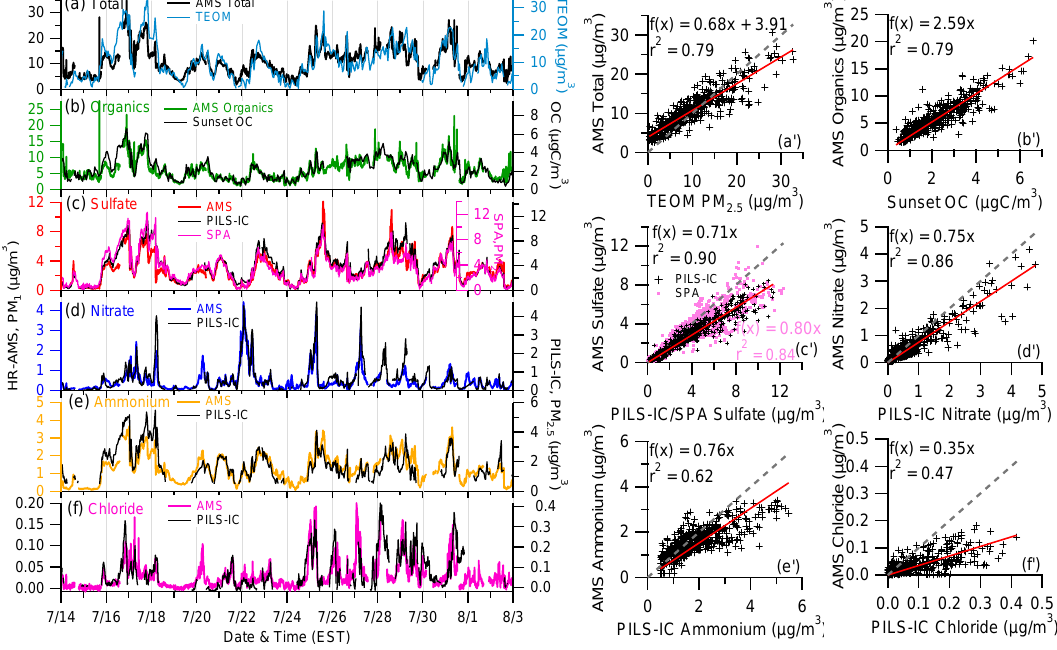
Fig. 1. Inter-comparisons between the NR-PM 1 mass concentrations measured by the HR-MS vs. the data acquired by collocated instruments: (a) total (=organics+sulfate+nitrate+ammonium +chloride) vs. PM 2 . 5 mass by a TEOM, (b) organics vs. PM 2 . 5 OC by a Sunset Lab OC/EC Analyzer, and (c–f) sulfate, nitrate, ammonium, and chloride vs. those measured by a PILS-IC. (c) also shows the comparison with PM 2 . 5 sulfate by a SPA. (a’-f’) are the scatter plots with the linear regression parameters and the 1:1 line (dash line) shown for the